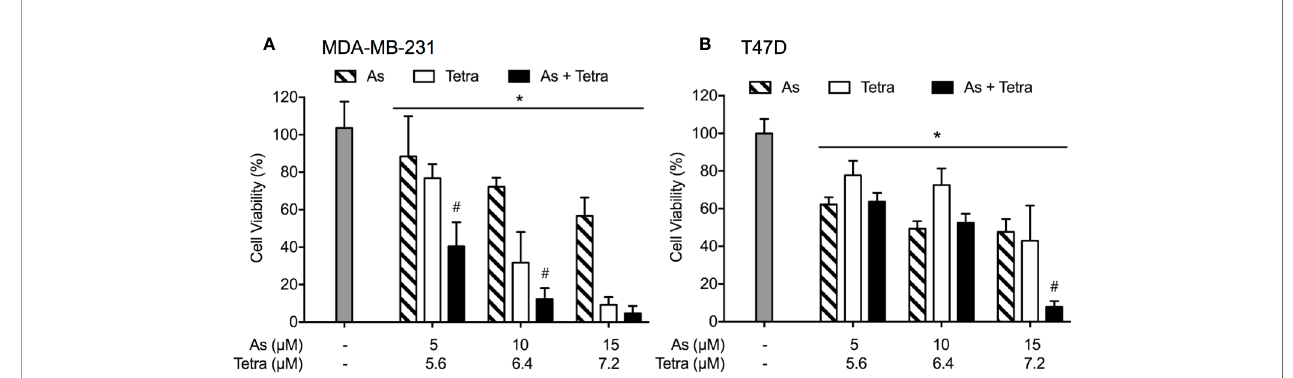
FIGURE 1 | Synergistic cytotoxicity of As III combined with Tetra in human breast cancer cell lines. Following treatment with various concentrations of As III alone (5, 10, and 15 µM), Tetra alone (5.6, 6.4, and 7.2 m M), or their combination for 48 h, the cell viability of MDA-MB-231 (A) and T47D (B) was determined by XTT assay. Relative cell viability was calculated as the ratio of the absorbance at 450 nm of each treatment group against those of the corresponding untreated control group. Data are shown as the means and SD from more than three independent experiments. *p<0.05 vs. control; # p<0.001 vs. each alone. As, As III ; Tetra,